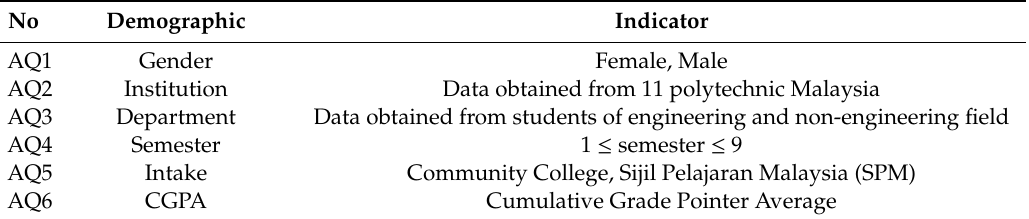
Table 3. Demographic items.